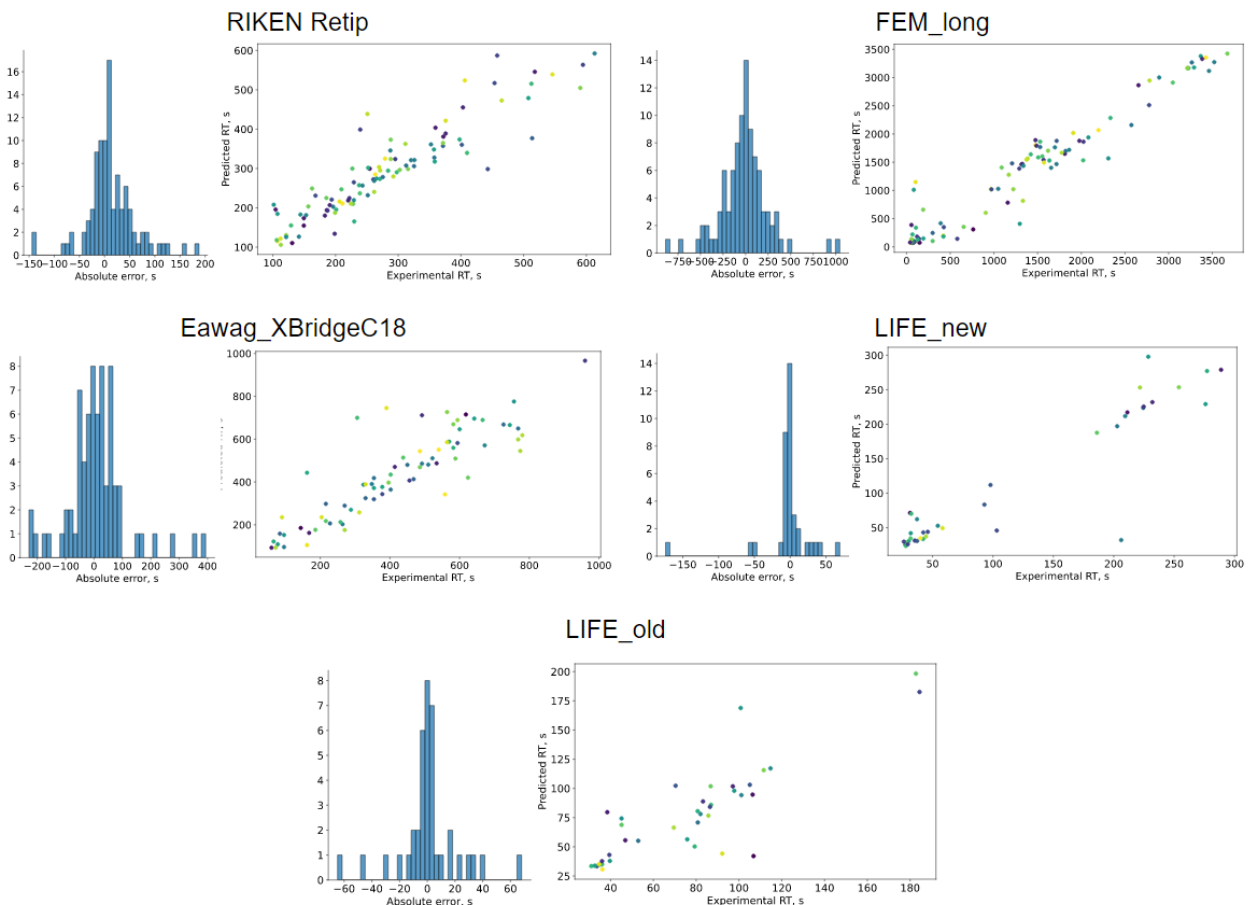
Figure 3. Predicted vs. experimental values and error distribution plots for the evaluated sets. Table 2. Mean absolute error (in seconds) for 5-fold cross-validation of MPNN compared with pre- viously published results.